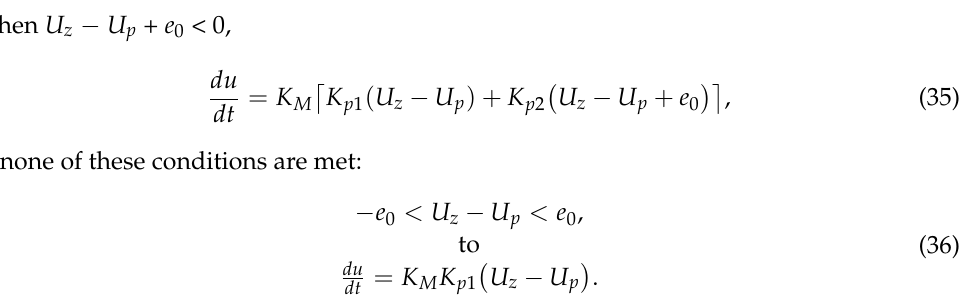
Figure 5. Logic tree and simplified logic tree.